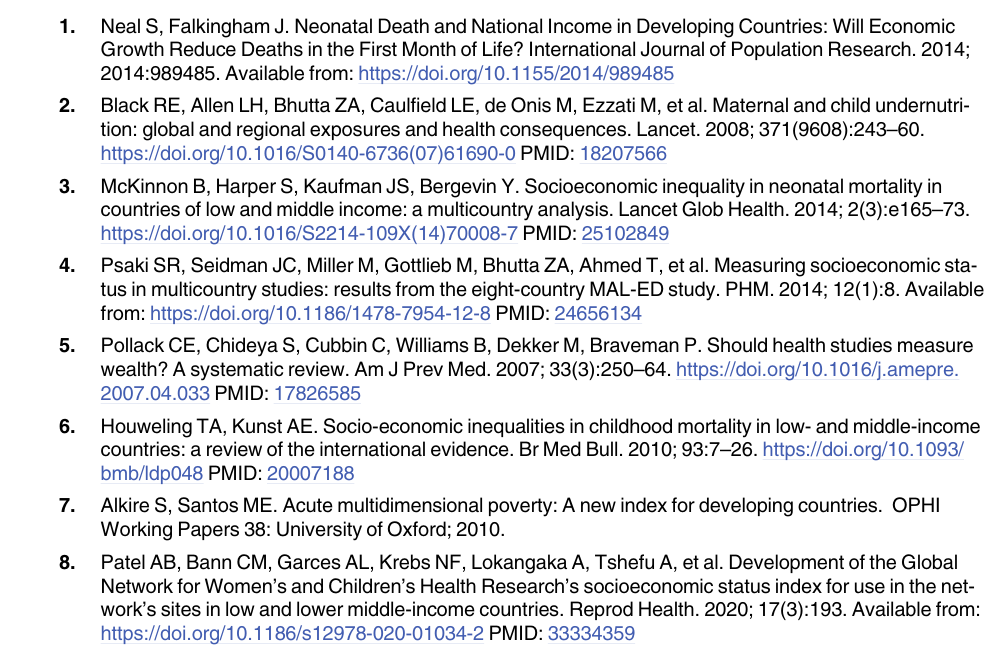
S3 Fig. Adjusted relative risks (95% confidence intervals) of neonatal mortality by site and SES. Relative risks are adjusted for SES category, site, site by SES interaction, maternal age, parity, formal education level, BMI category, and facility